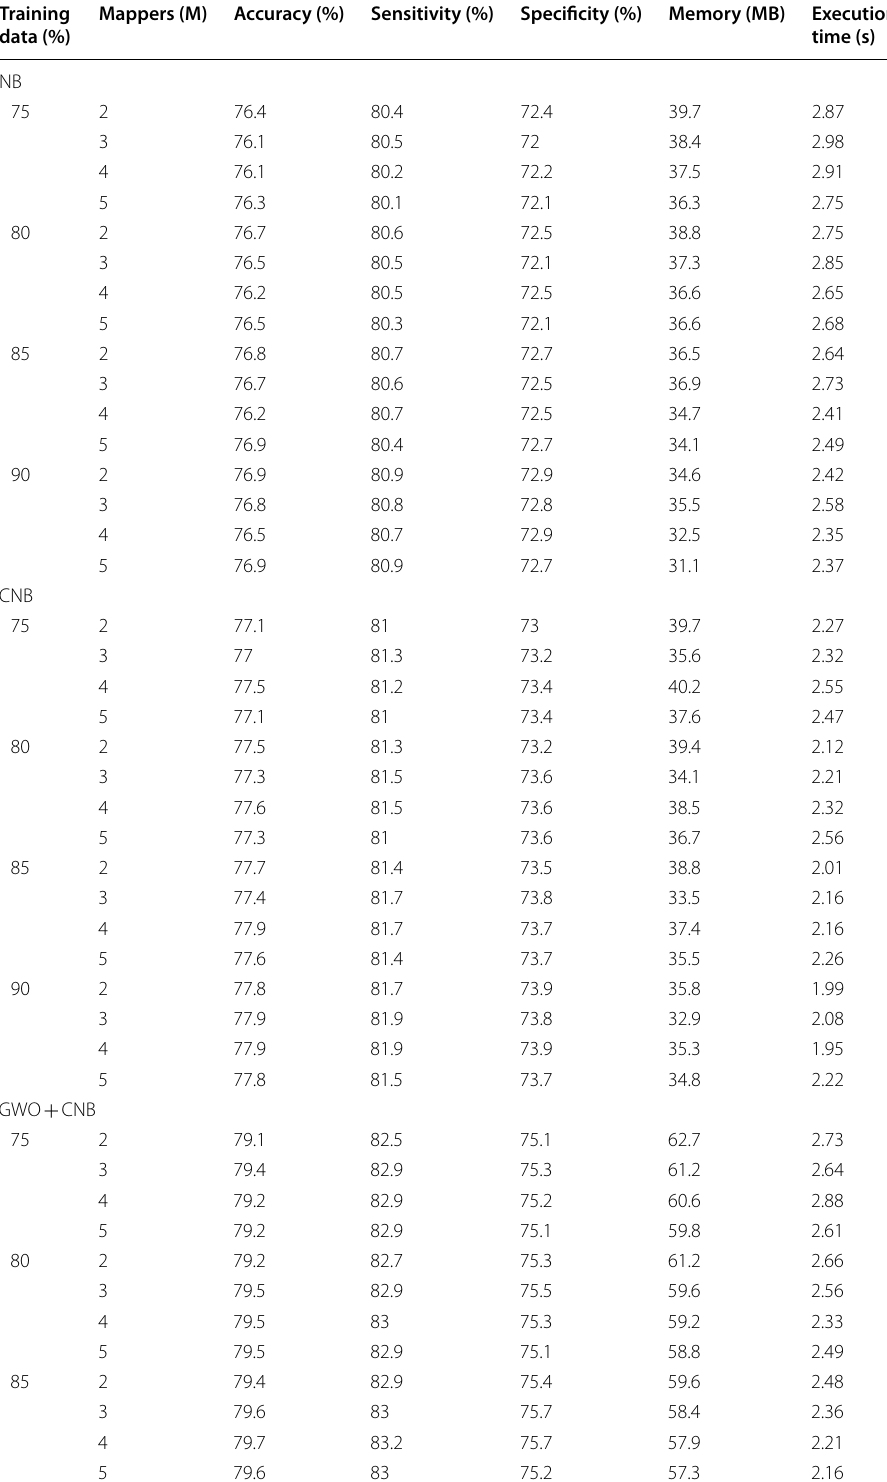
CNB, CGCNB, FCNB, and HCNB based on localization data +